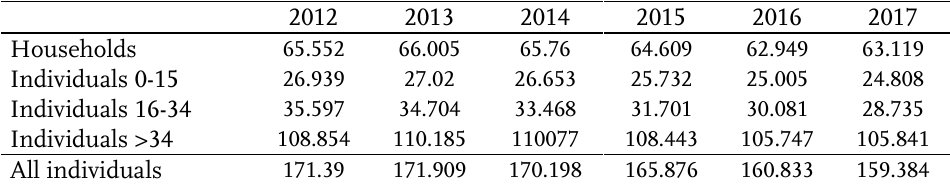
Sample size (number of observations) by groups in the second quarter of the year.